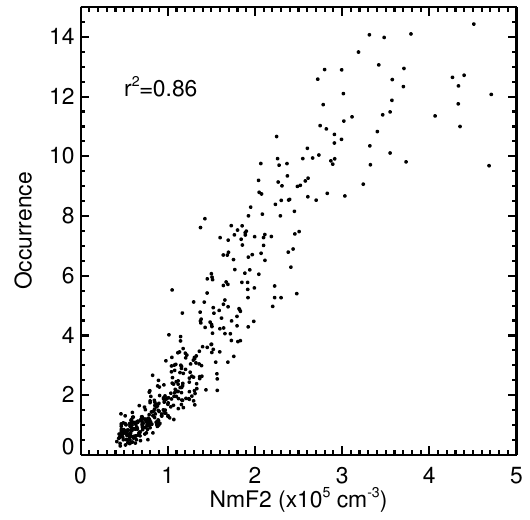
Fig. 6. Nighttime echo occurrence versus model F-region electron density Nm F2. The linear r 2 correlation co-efficient is shown in the top-left of the